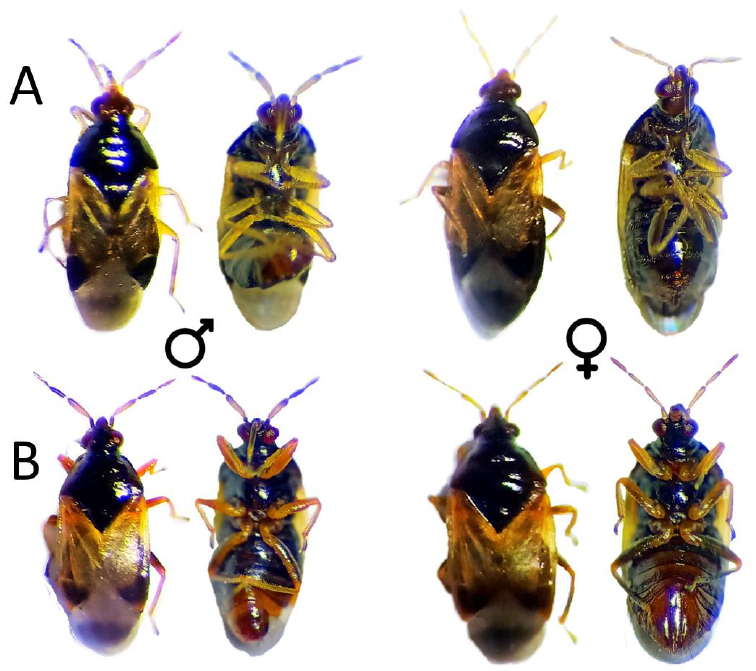
Figure 2. Recently emerged normal ( A ) and orange mutant ( B ) male and female adults of Orius laevigatus .